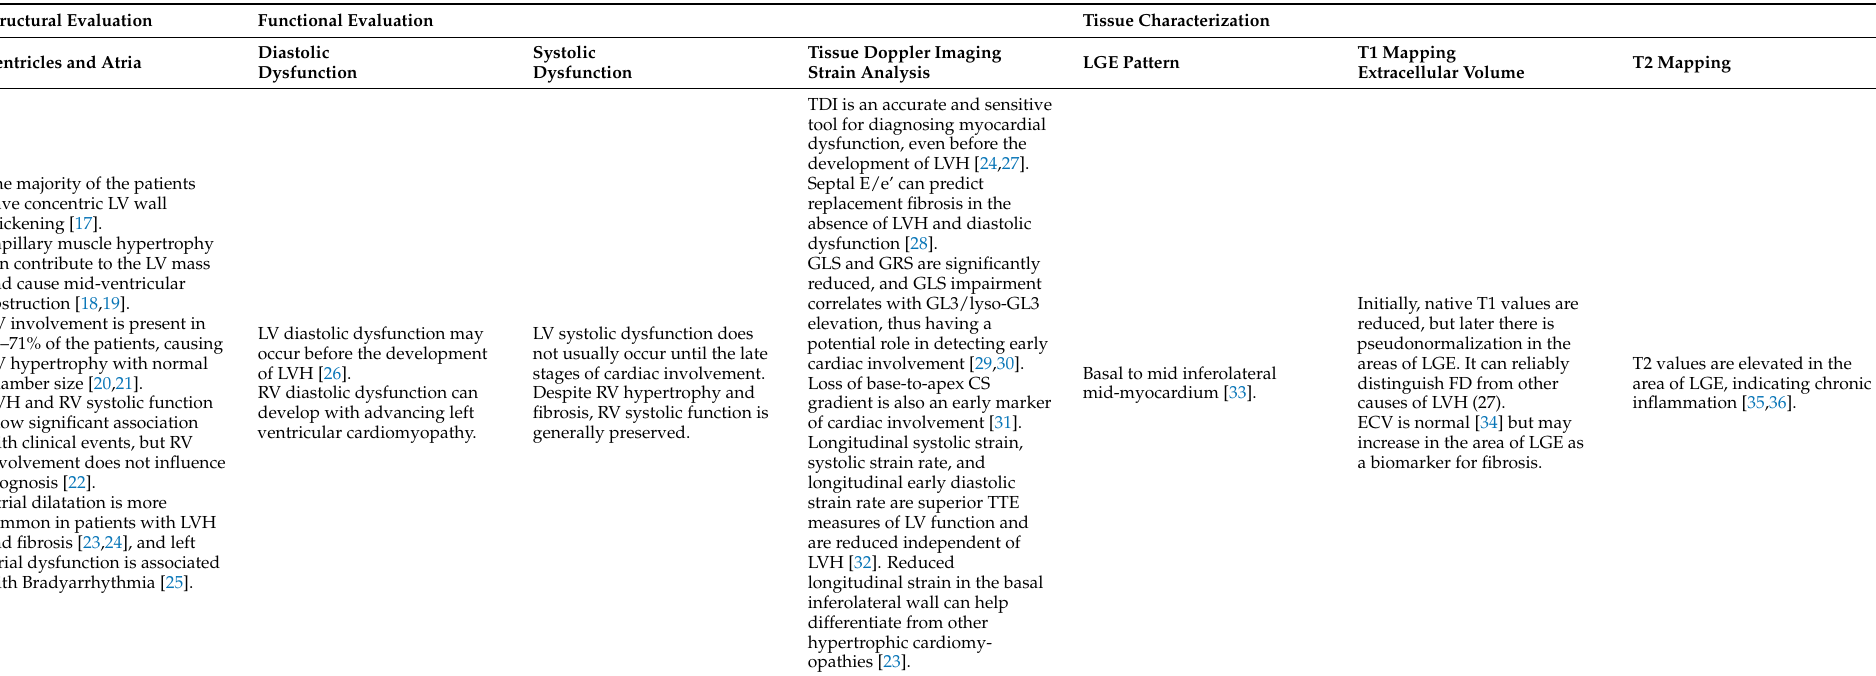
Table 1. The role of multimodality imaging in evaluating FD cardiomyopathy and response to treatment. Left ventricle (LV), right ventricle (RV), left